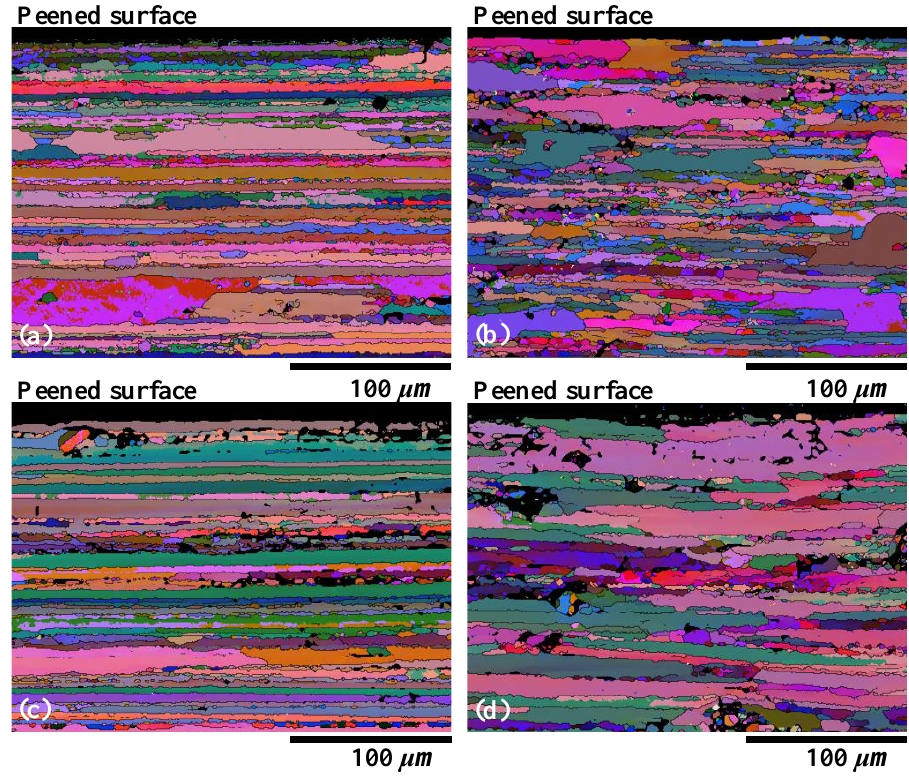
Figure 7. Cross-sectional EBSD Euler angle orientation maps of the 3- and 9-mm LPF sheets: ( a ) 3-mm sheet in the RD, ( b ) 3-mm sheet in the TD, ( c ) 9-mm sheet in the RD, and ( d ) 9-mm sheet in the